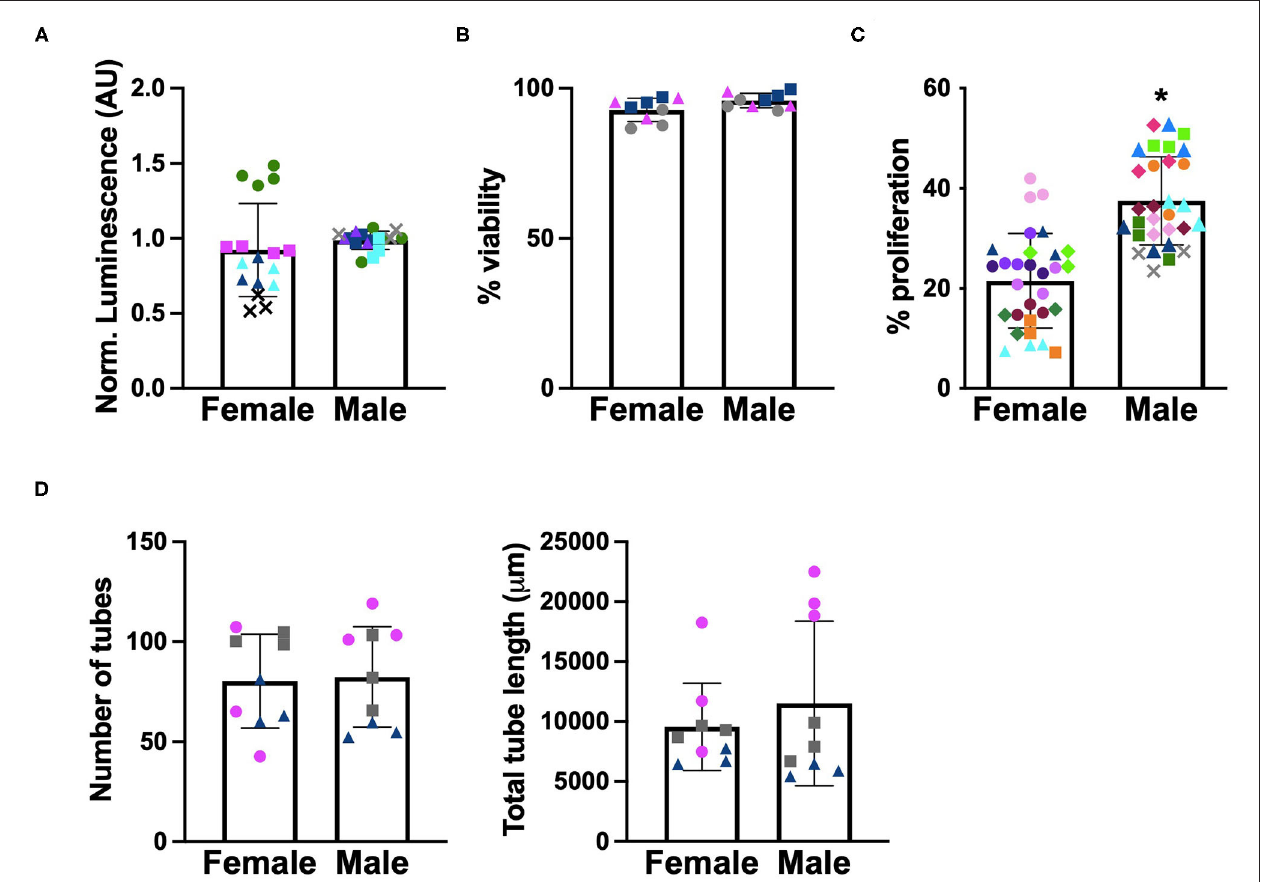
FIGURE 3 | Sex differences in baseline characterization of VECs. (A) ATP activity, (B) viability, (C) proliferation, and (D) tubulogenesis. Different marker shapes indicate different donors; different colors within the same marker shape indicate different runs with the same donor. * p < 0.05 vs. female VECs by Welch’s t -test. N = 3–4 pigs per sex, n = 3 wells per